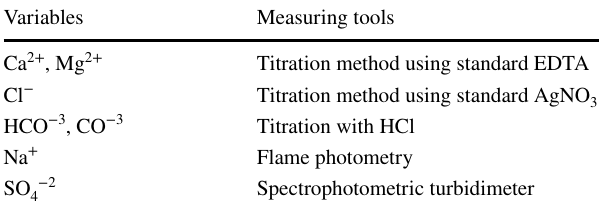
Table 1 Methods used to determine chemical parameters of water Variables